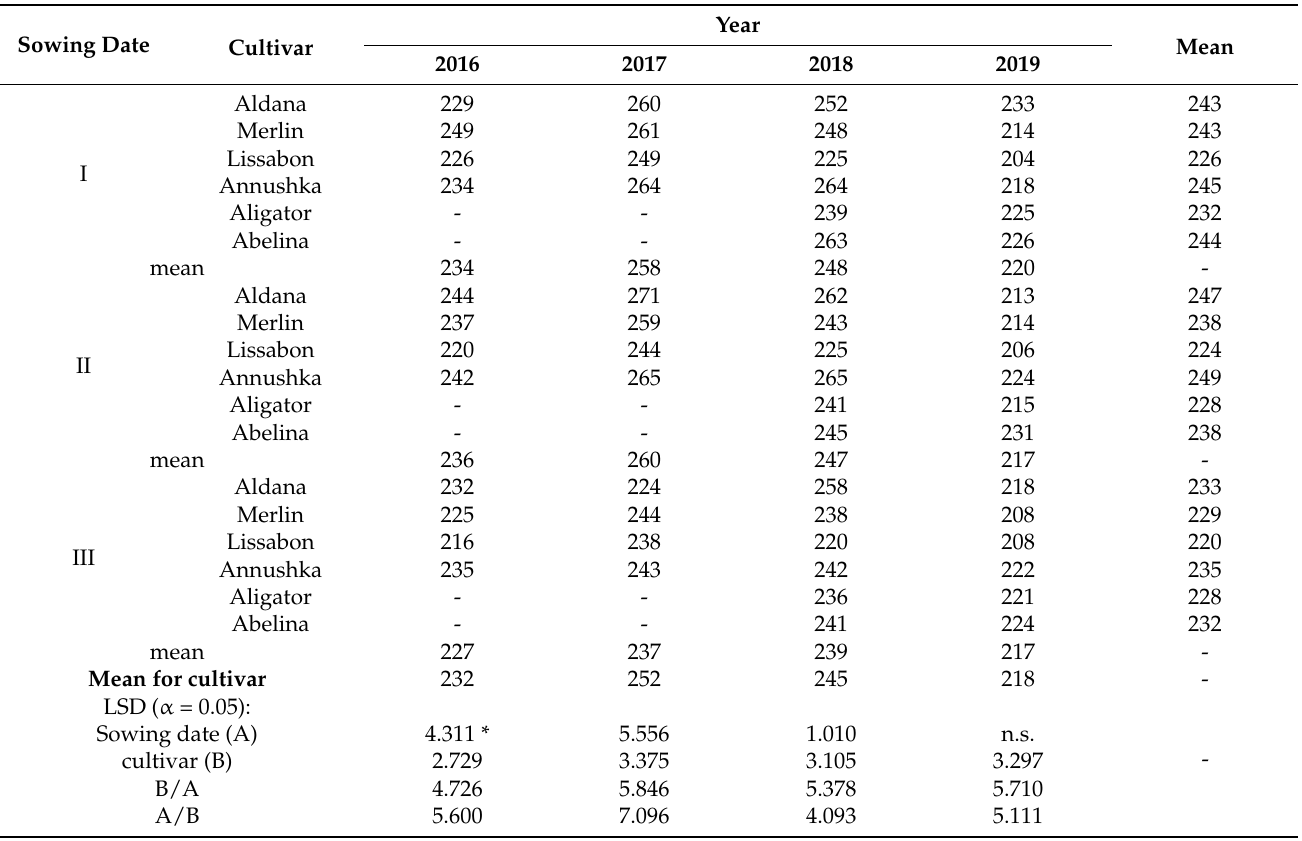
Table 6. Crude fat content in soybean seeds depending on cultivar and sowing date (g kg − 1